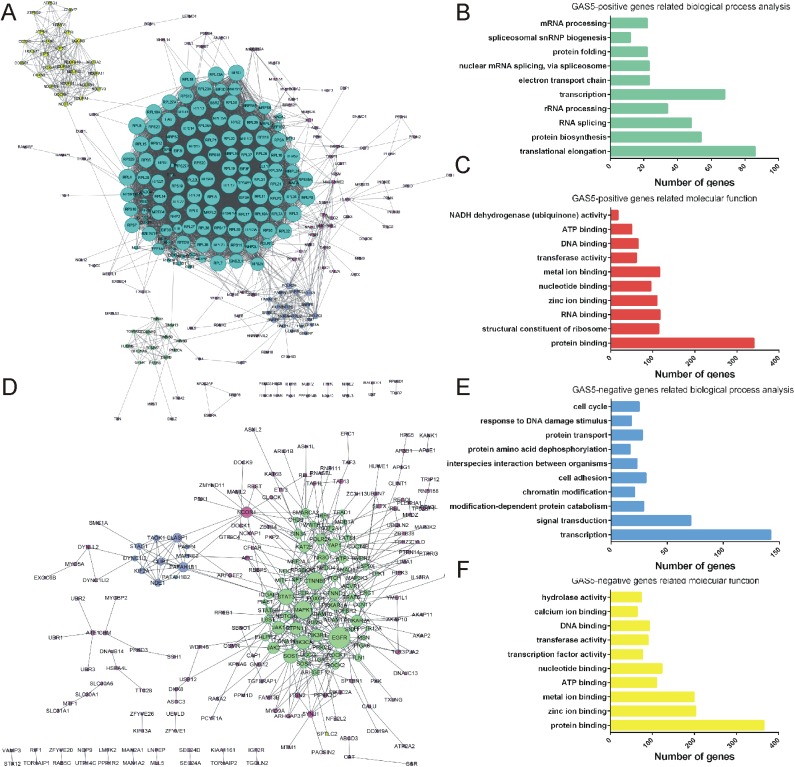
GO biological process and KEGG pathway enrichment analysis of LncRNA GAS5.(A) Gene co-expression networks of GAS5 were constructed according to Pearson correlation coefficients. (B) GO biological process analysis of GAS5-positive genes and GAS5-negative genes (E). (C) KEGG pathway enrichment analysis of GAS5-positive genes and GAS5-negative genes (F) using MAS 3.0. (D) The PPI network.